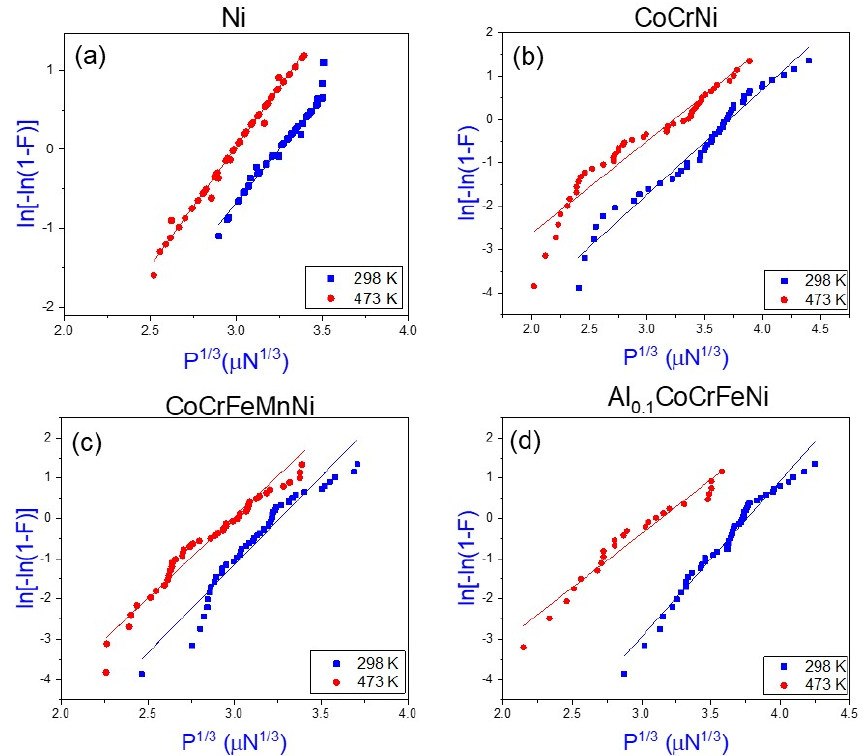
Figure 5. Plot of ln[ − ln(1 − F )] vs. P 1/3 at 298 K and 473 K to determine the activation volume from experimental data analysis for ( a ) Ni, ( b ) CoCrNi, ( c ) CoCrFeMnNi, and ( d ) Al 0.1 CoCrFeNi.